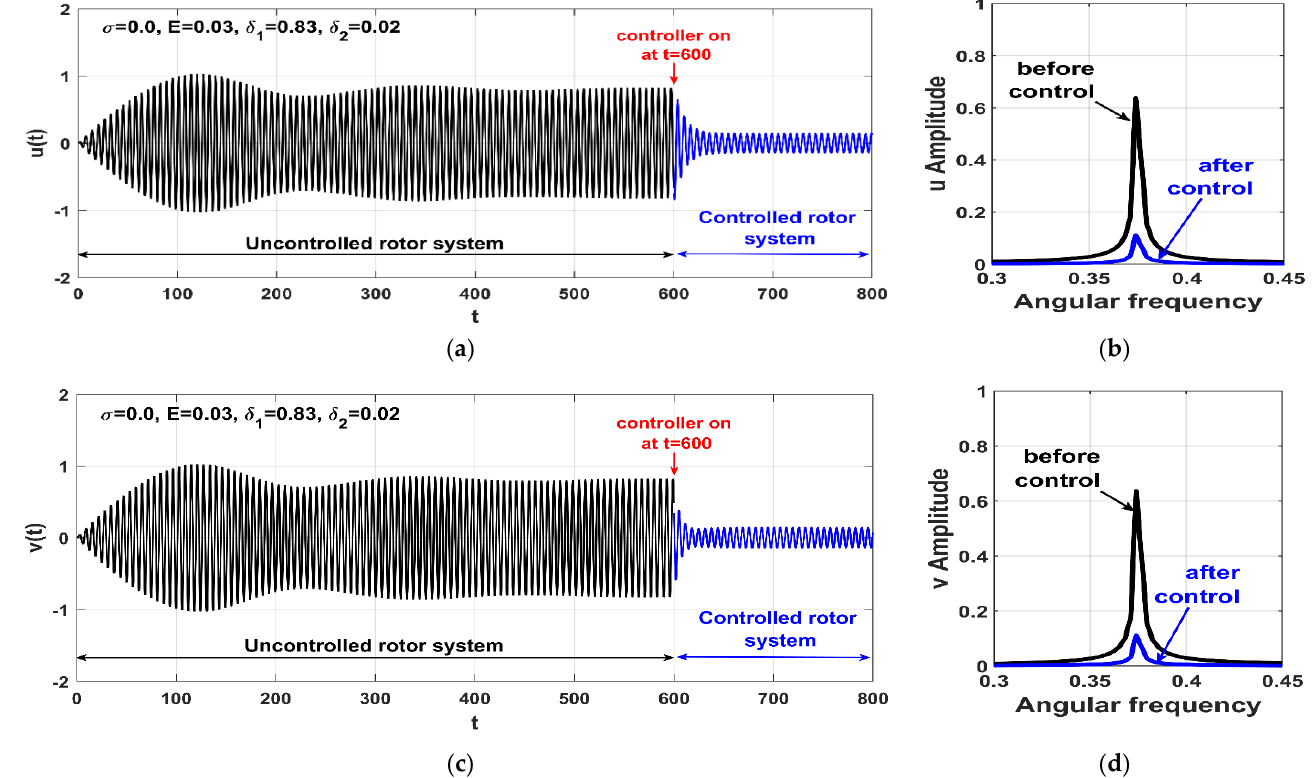
Figure 21. Time-response and the corresponding frequency-spectrum of the Jeffcott-rotor system before and after control according to Figure 20 at σ = 0.0, E = 0.03, λ = 0.05, δ 1 = 0.83, δ 2 = 0.02 when turning the controller on at time t = 600: ( a , b ) the normalized temporal oscillations u ( t ) and the corresponding frequency spectrum in X direction, ( c , d ) the normalized temporal oscillations v ( t ) and the corresponding frequency spectrum in Y direction.